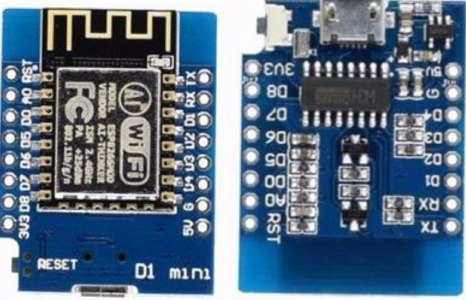
Figure 3. Wemos D1